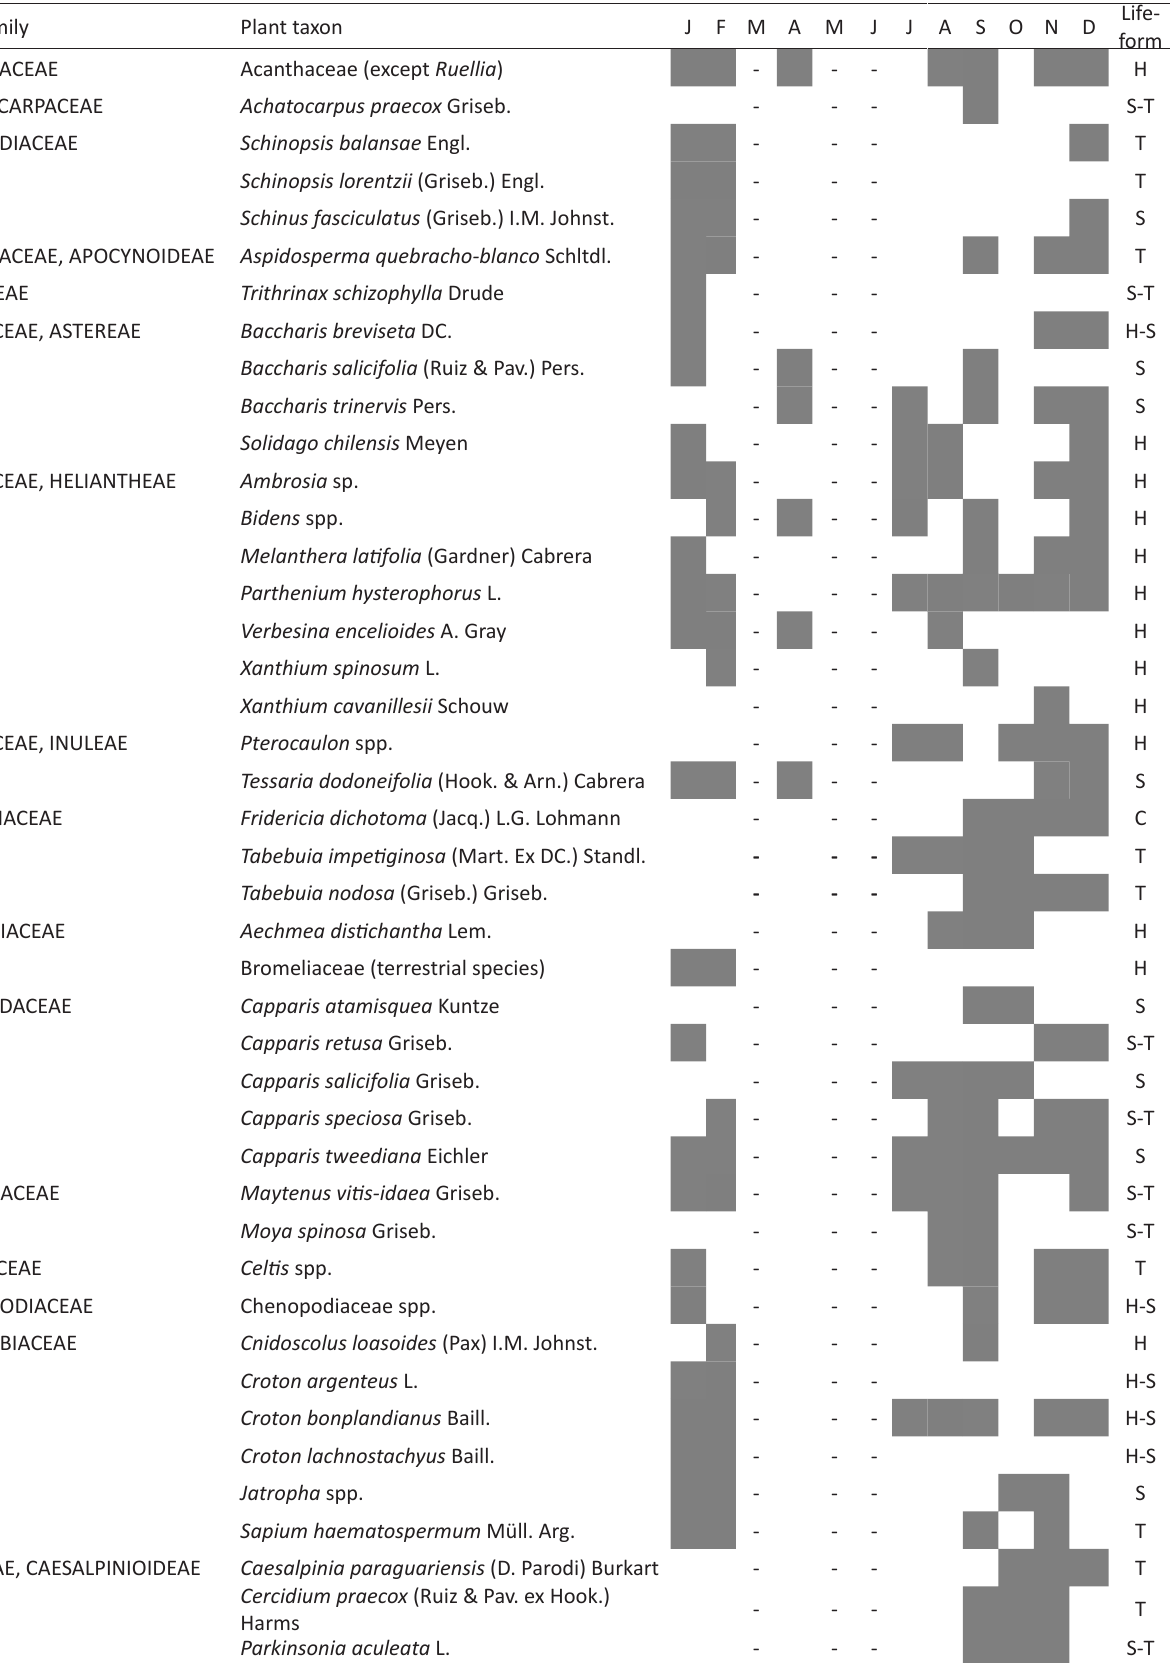
Table 3 . Flowering phenology of the plant taxa whose ascribed pollen types were found in the stores of Tetragonisca fiebrigi in the Dry Chaco forest. During March, May and June, flowering was not recorded. Plant life-forms: T = trees, S = shrubs (more than 1 m in height), C = climbers and lianas, H = herbs, semi-shrubs and shrubs less than 1 m in height, E =